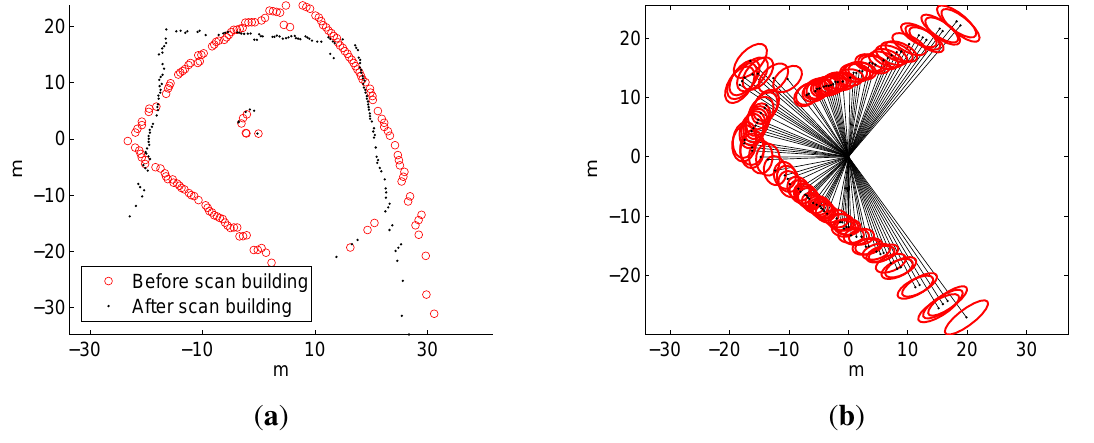
Figure 10. Example of the scan building process. ( a ) A scan before and after the scan building; ( b ) One scan showing the 95% confidence ellipses for each